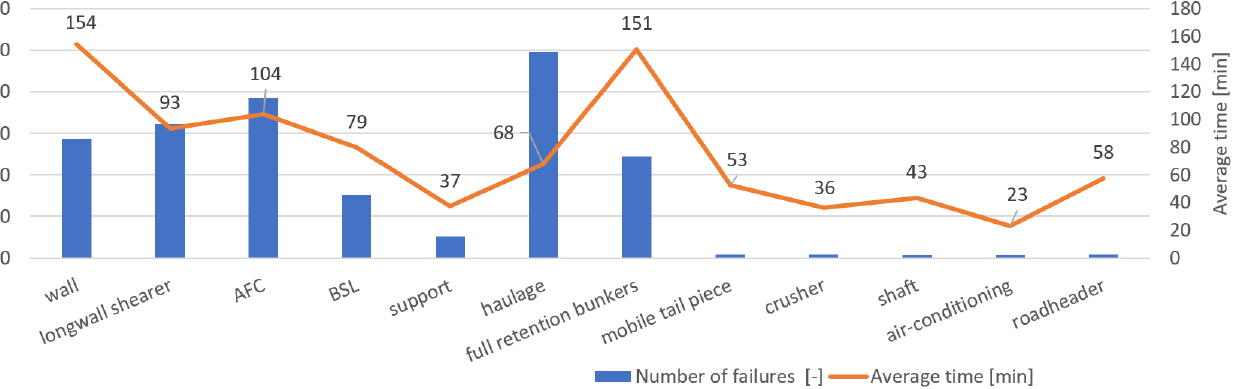
Figure 5. Duration of failures and average duration of failures of shearer longwalls in total.